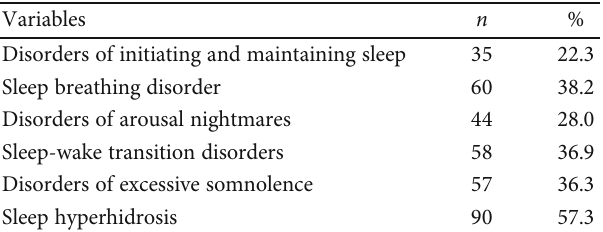
Table 3: Prevalence of 6 sleep disorder domains ( n = 157